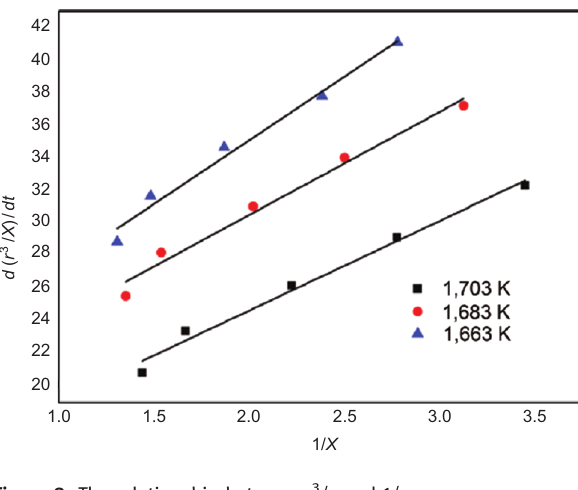
Figure 8: The relationship between r 3 / χ and 1/ χ